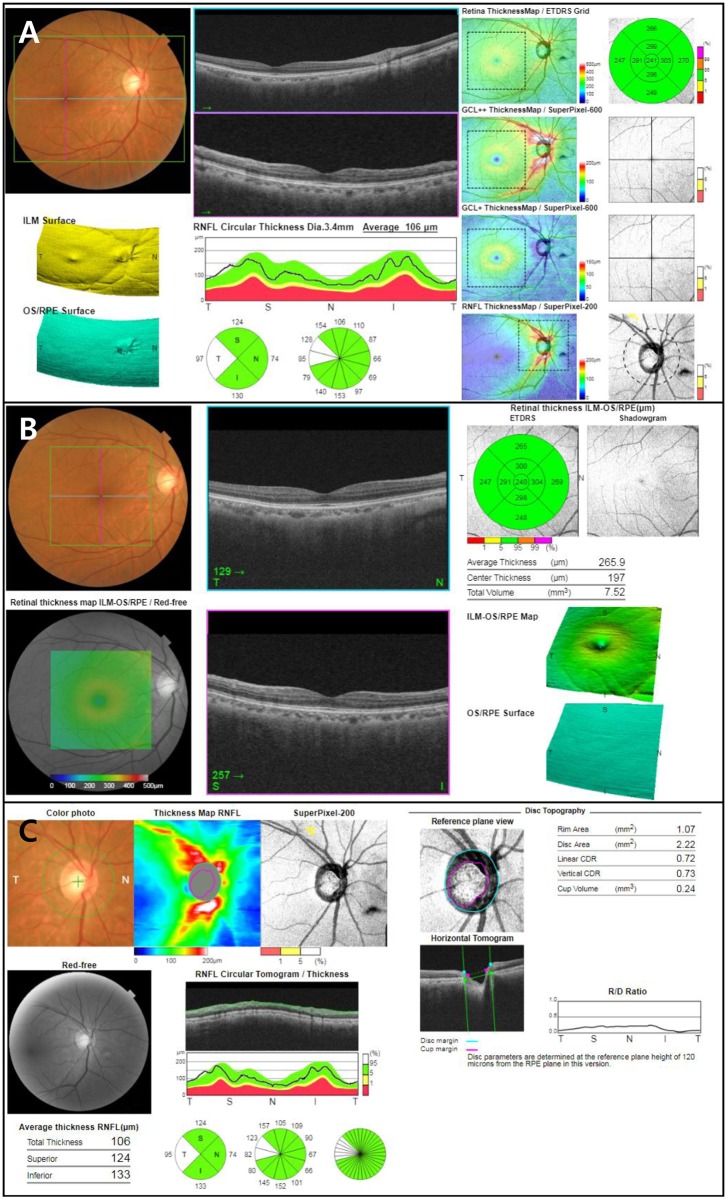
Examples of Topcon SS-OCT reports for each scan in a healthy eye.(A) Wide scan report, (B) standard macula scan report and (C) standard disc scan report. Wide report provides both macular and circumpapillary parameters.